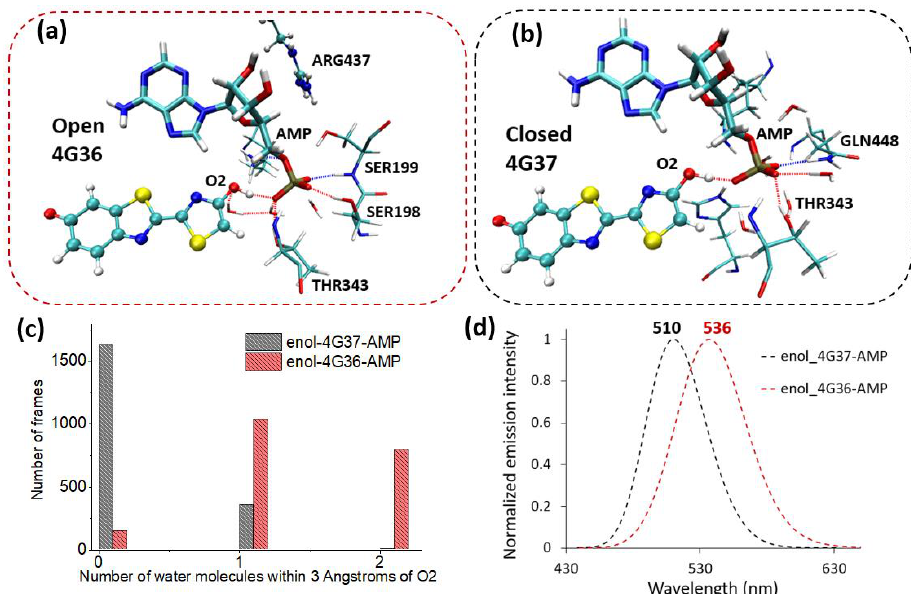
Figure 6. Graphical representation of the hydrogen-bond patterns found along the simulations of ( a ) enol-4G36-AMP and ( b ) enol-4G37-AMP. ( c ) Histogram showing the number of water molecules within 3 Angstroms of O2 during the simulation. ( d ) Simulated emission spectra for enol-4G36-AMP and enol-4G37-AMP.